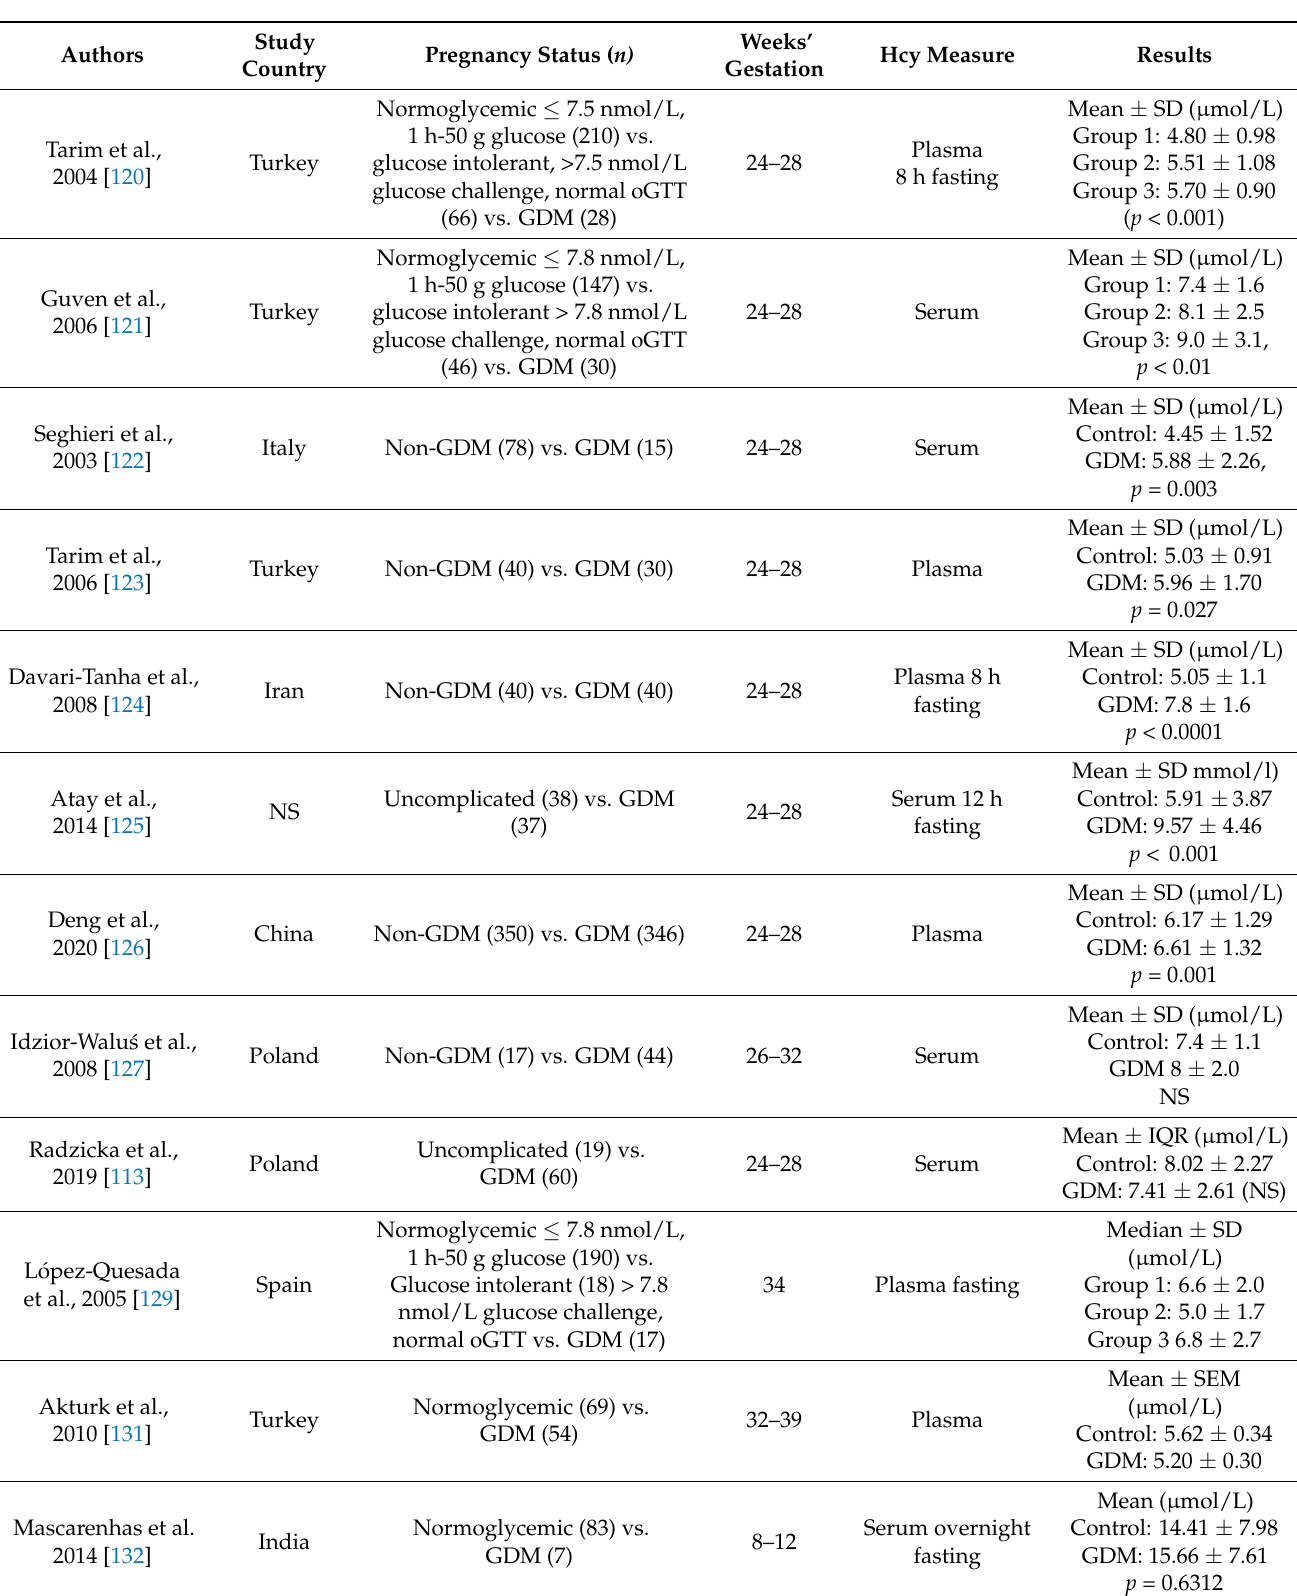
Table 3. Summary of research on the relationship between circulating homocysteine and